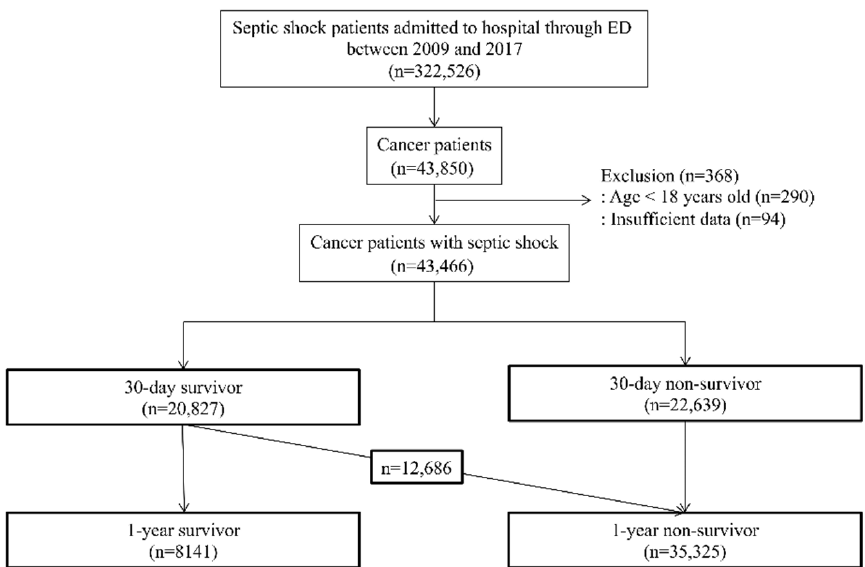
Figure 1. Flow diagram for the study cohort derivation from the Korean National Health Information Database. ED indicates emergency